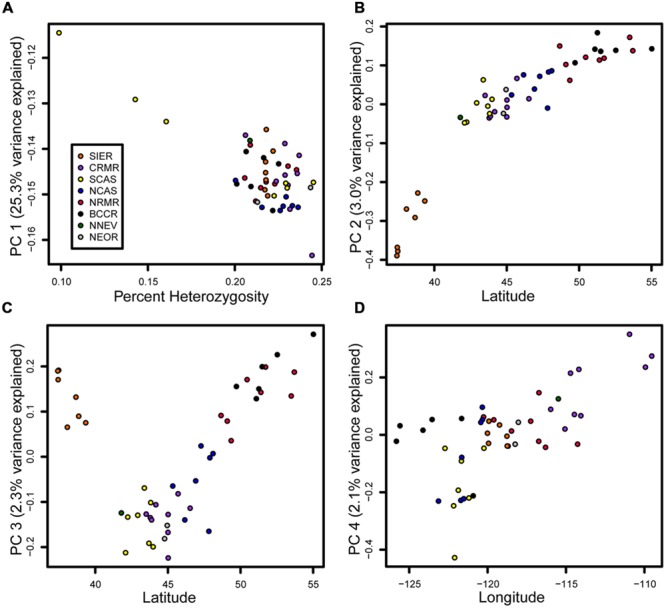
Principal components (PCs) tied to heterozygosity, latitude, and longitude. Samples are colored by geographic group as in Figure 1. (A) PC 1 vs. heterozygosity. (B) PC2 vs. latitude. (C) PC3 vs. latitude. (D) PC4 vs. longitude.